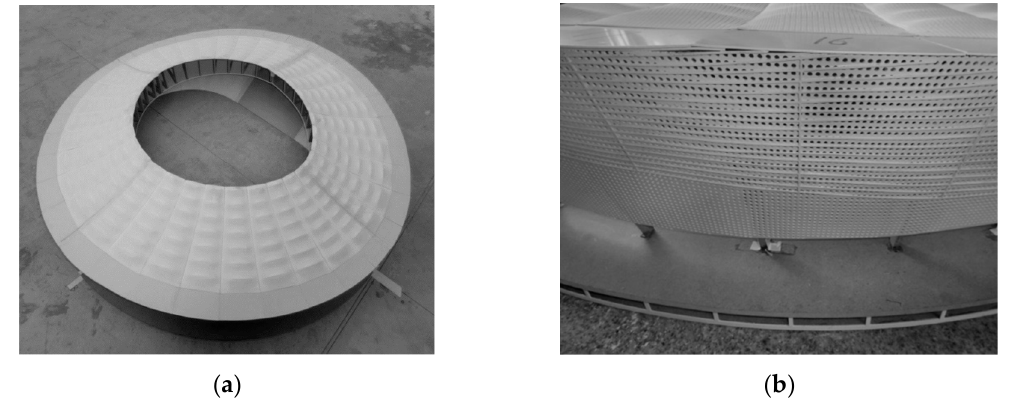
Figure 5. Model of membrane structure gymnasium: ( a ) Tongren Olympic Sports Center Stadium model (made of acrylonitrile butadiene styrene (ABS) plastic); ( b ) wall of membrane structure (40% air permeability).